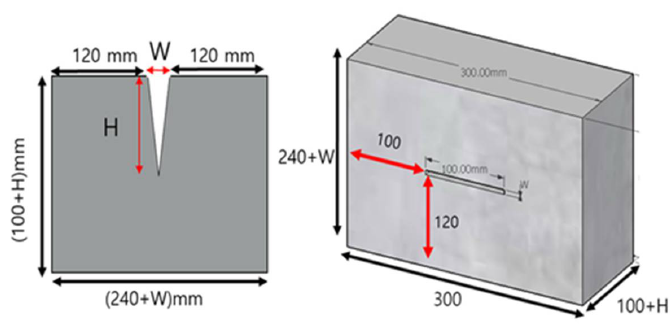
Figure 2. Configuration of test specimens.